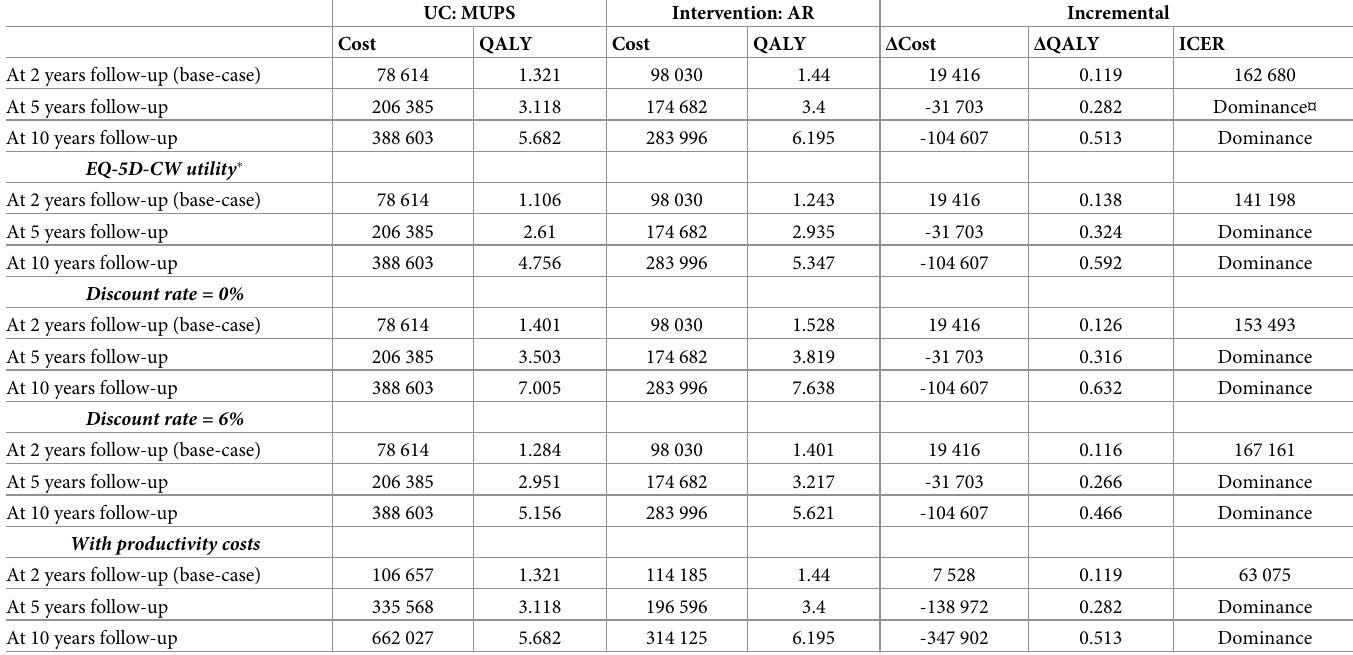
Table 4. Cost-effectiveness of amalgam removal in the base-case and various scenario